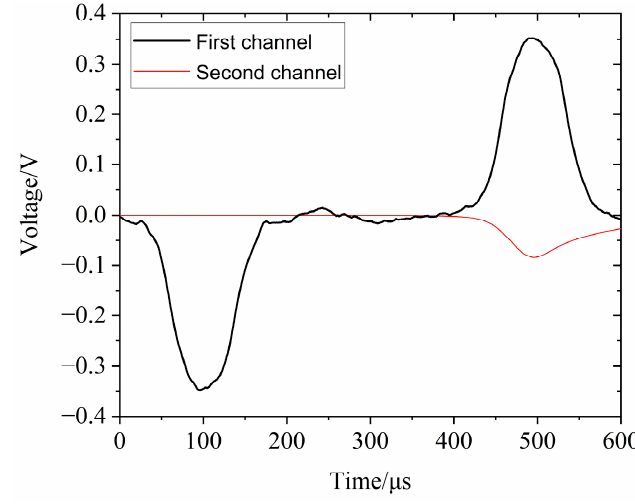
Figure 2. Typical original signal waveform of silicone rubber.